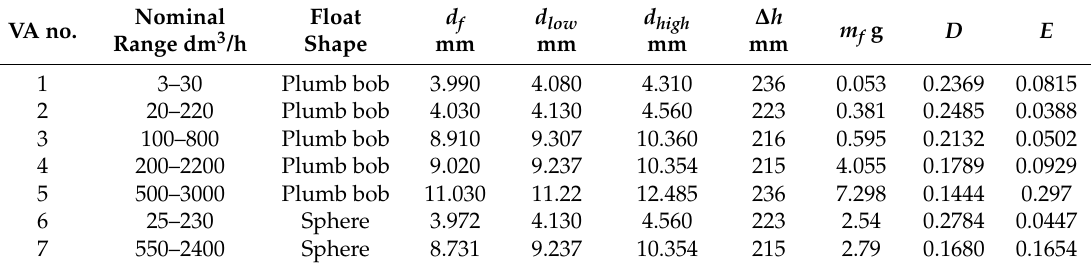
Table 1. List of investigated VA flowmeters and their most important parameters.